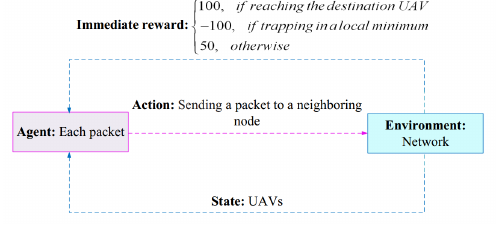
Figure 34. Learning process in Q-FANET. Table 16. The most important advantages and disadvantages of